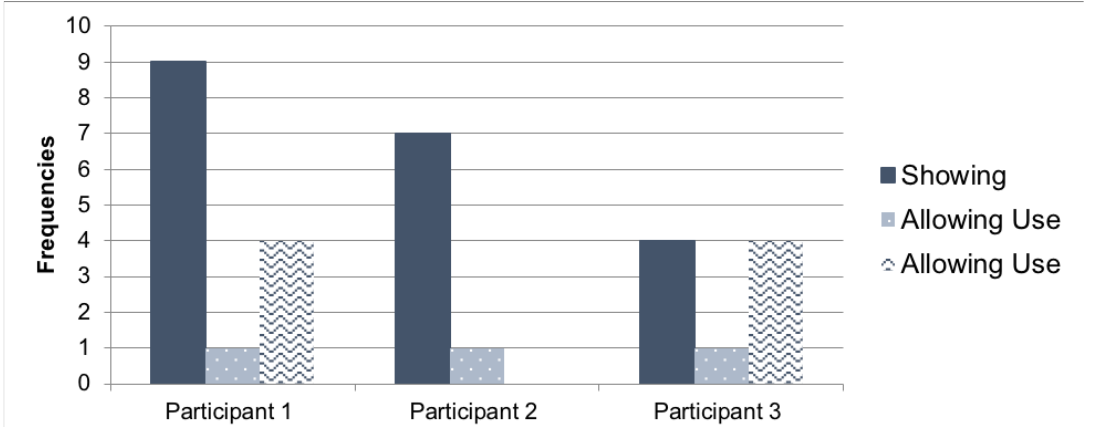
Figure 8. Individual prosocial behaviours per participant